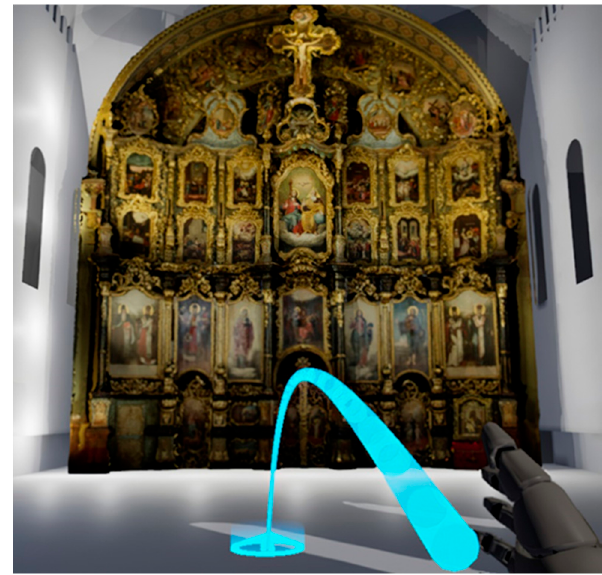
Figure 11. Navigation through the church using motion controllers.